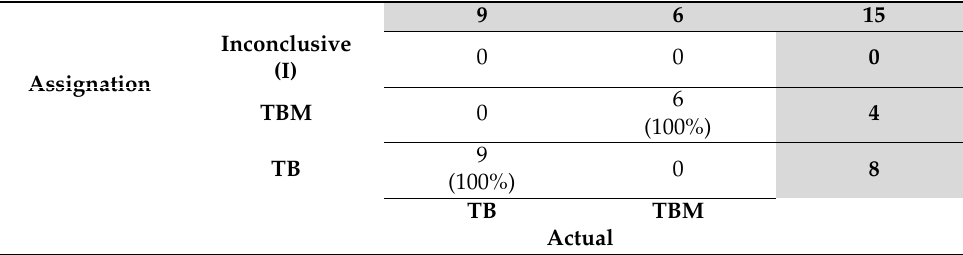
Table 4. Quality performance metrics (QPM) summary chart of the selected models.